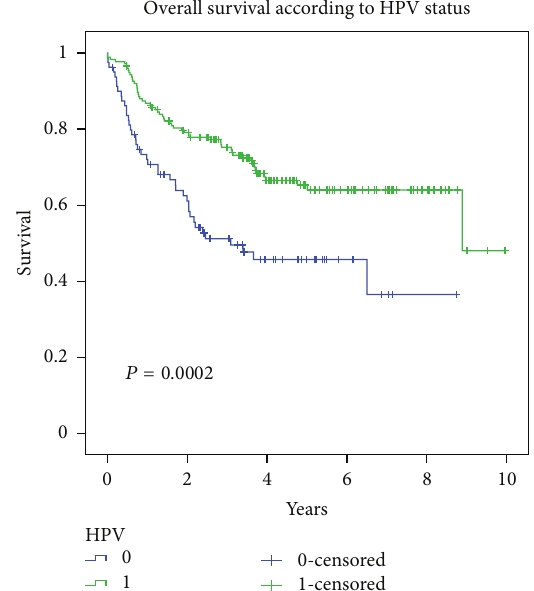
(HR = 0.52 ; 95% CI = [0.333, 0.818] ; 𝑃 = 0.0048 ). LRC for HPV-negative and HPV-positive cases was 2.17